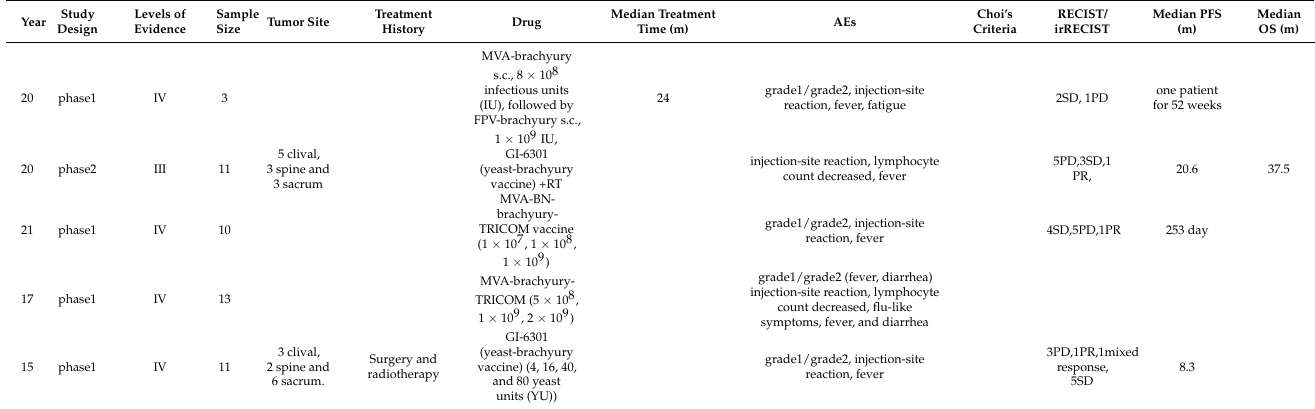
Table 3. Immunotherapy of chordomas with Brachuyury vaccine.